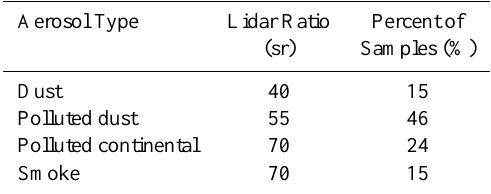
Table 4. Aerosol types and lidar ratios identified by CALIPSO dur- ing AAO overpasses.